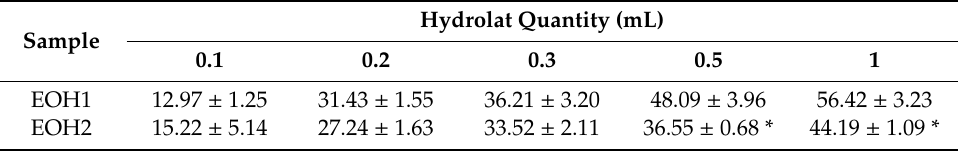
Table 2. Antioxidant activity of nutmeg essential oil hydrolats. Sample